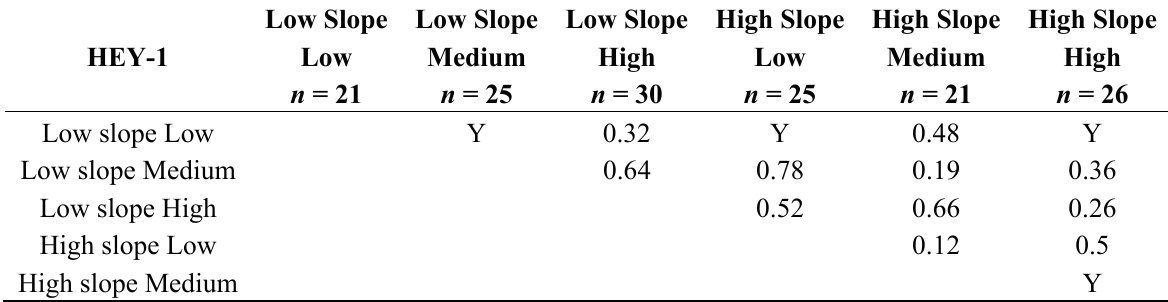
Table 4. p values from pair-wise t -tests of migration speeds of HEY-1 cells at low, medium, and high concentration regions of the low and high slope LN gradients. n = number of cells used in the analysis. “Y” corresponds to p <